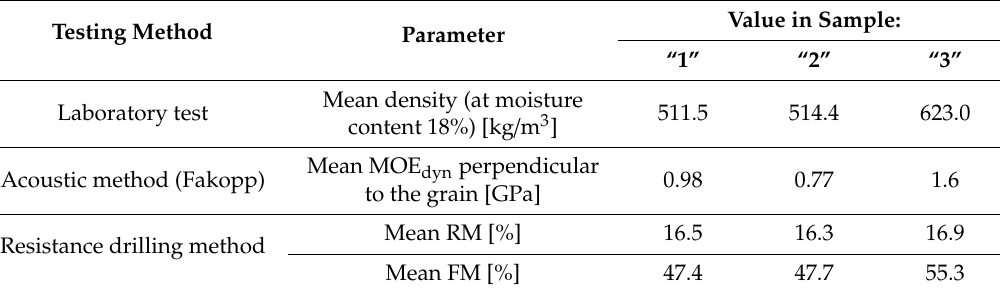
Table 12. Selected results for different samples.